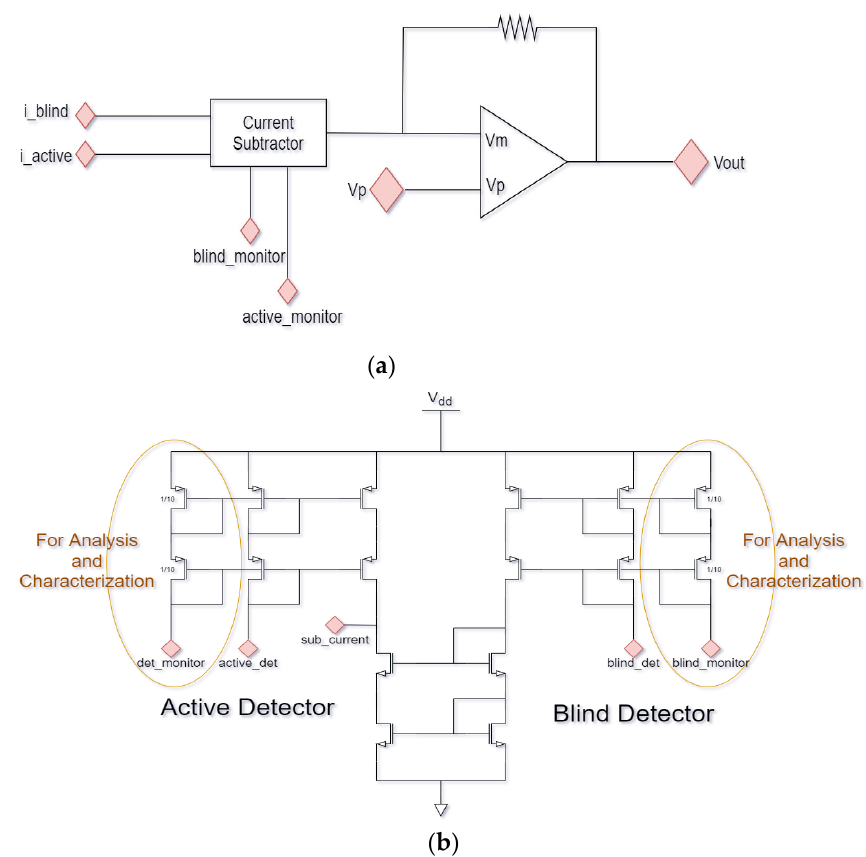
Figure 6. ( a ) Readout schematic as a current subtractor followed by a TIA. ( b ) current subtractor design based on cascaded current mirrors.